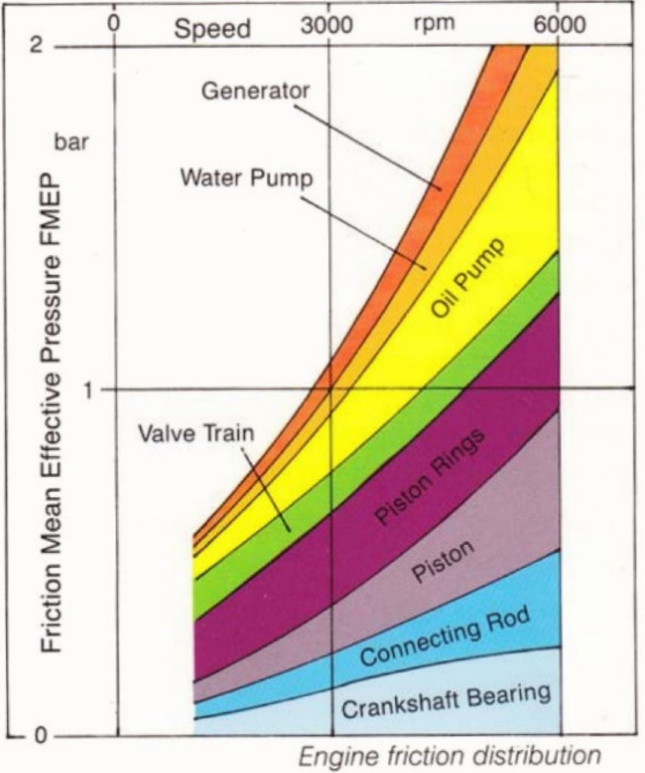
Figure 2. Schematic of engine friction distributions across a variety of speed ranges [33].